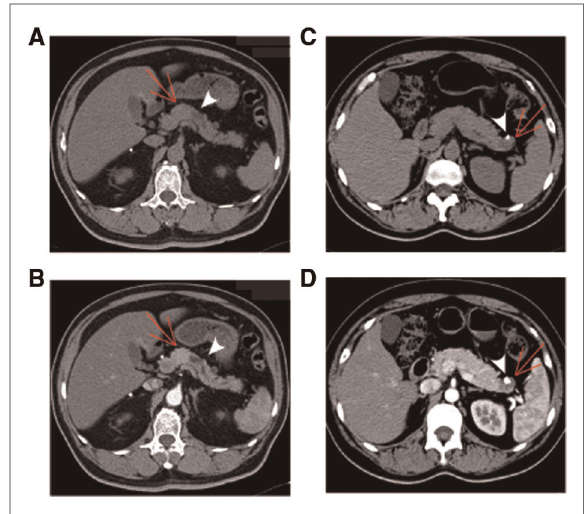
TABLE 3 Radiological features of CT and/or MRI